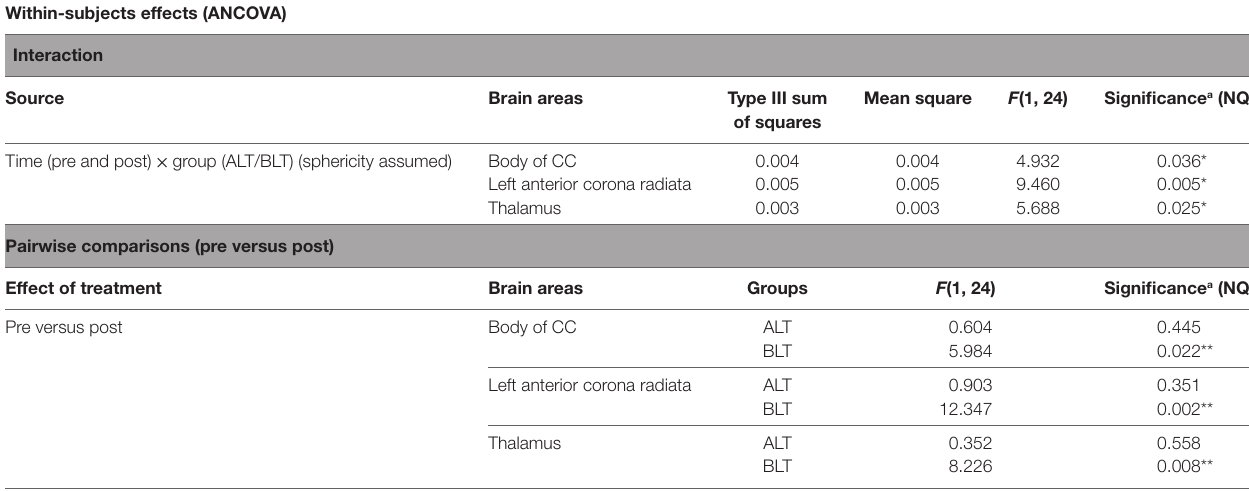
TaBle 2 | Summary of analysis of variance (repeated measures ANOVA) for normalized quantitative anisotropy (NQA). Within-subjects effects